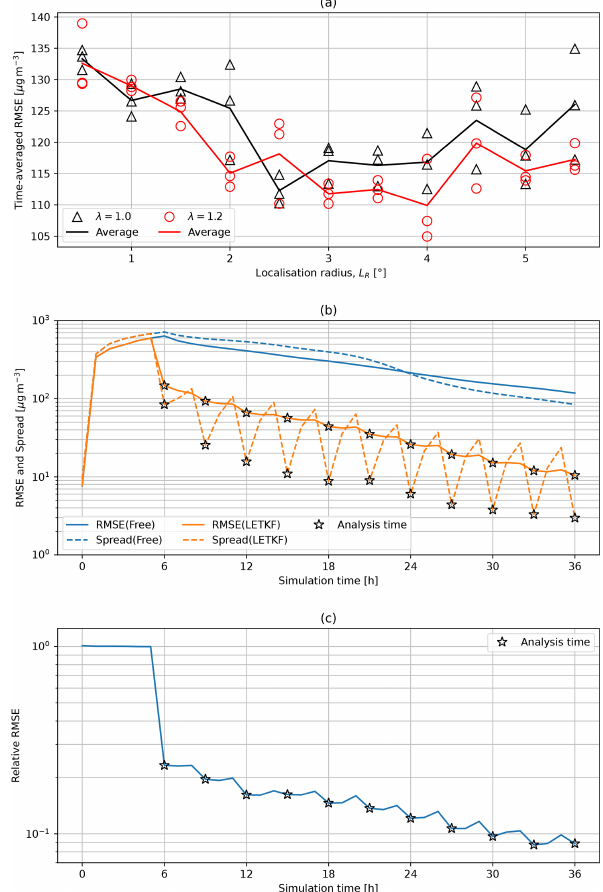
Figure 6. Evaluation metrics used for the twin experiment are as follows. (a) Time-averaged RMSE computed for different filter con- figurations and three ensemble realisations. Best performance was obtained for localisation radius, L R , in the range 2–4 ◦ and an infla- tion factor of λ = 1 . 2. (b) Temporal evolution of ensemble spread and RMSE for the free and LETKF runs. (c) Time series of LETKF- to-free ratio of RMSE. Assimilation times are denoted by star sym-